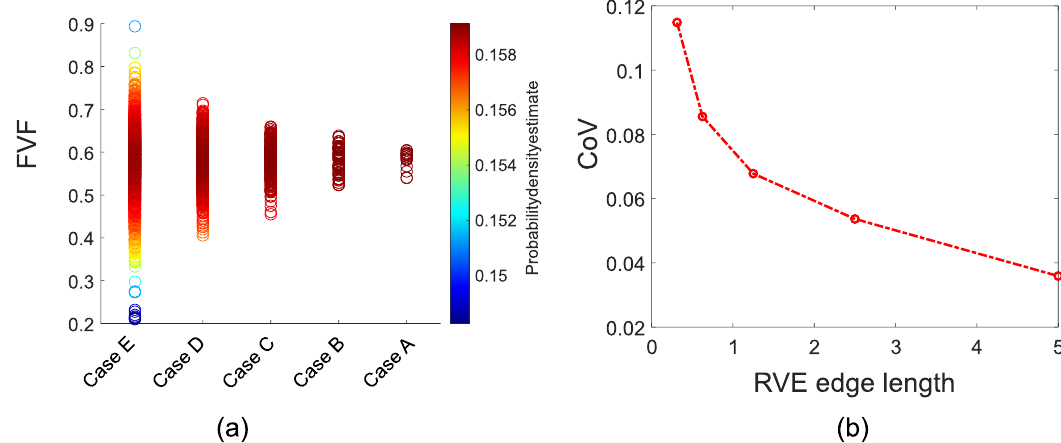
Figure 6. ( a ) V f values distribution, and ( b ) coefficient of variation with respect to the RVE edge